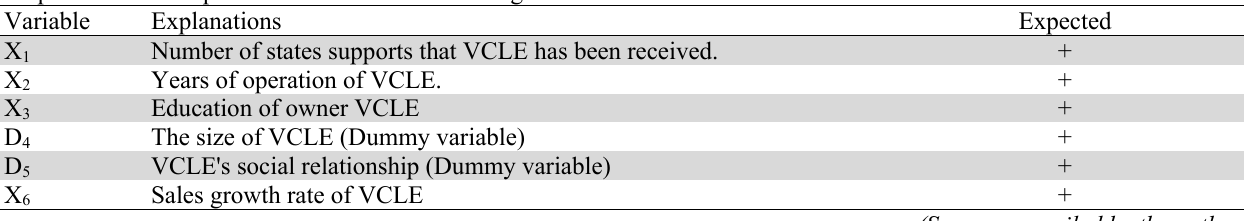
Interpretation of independent variables in a linear regression